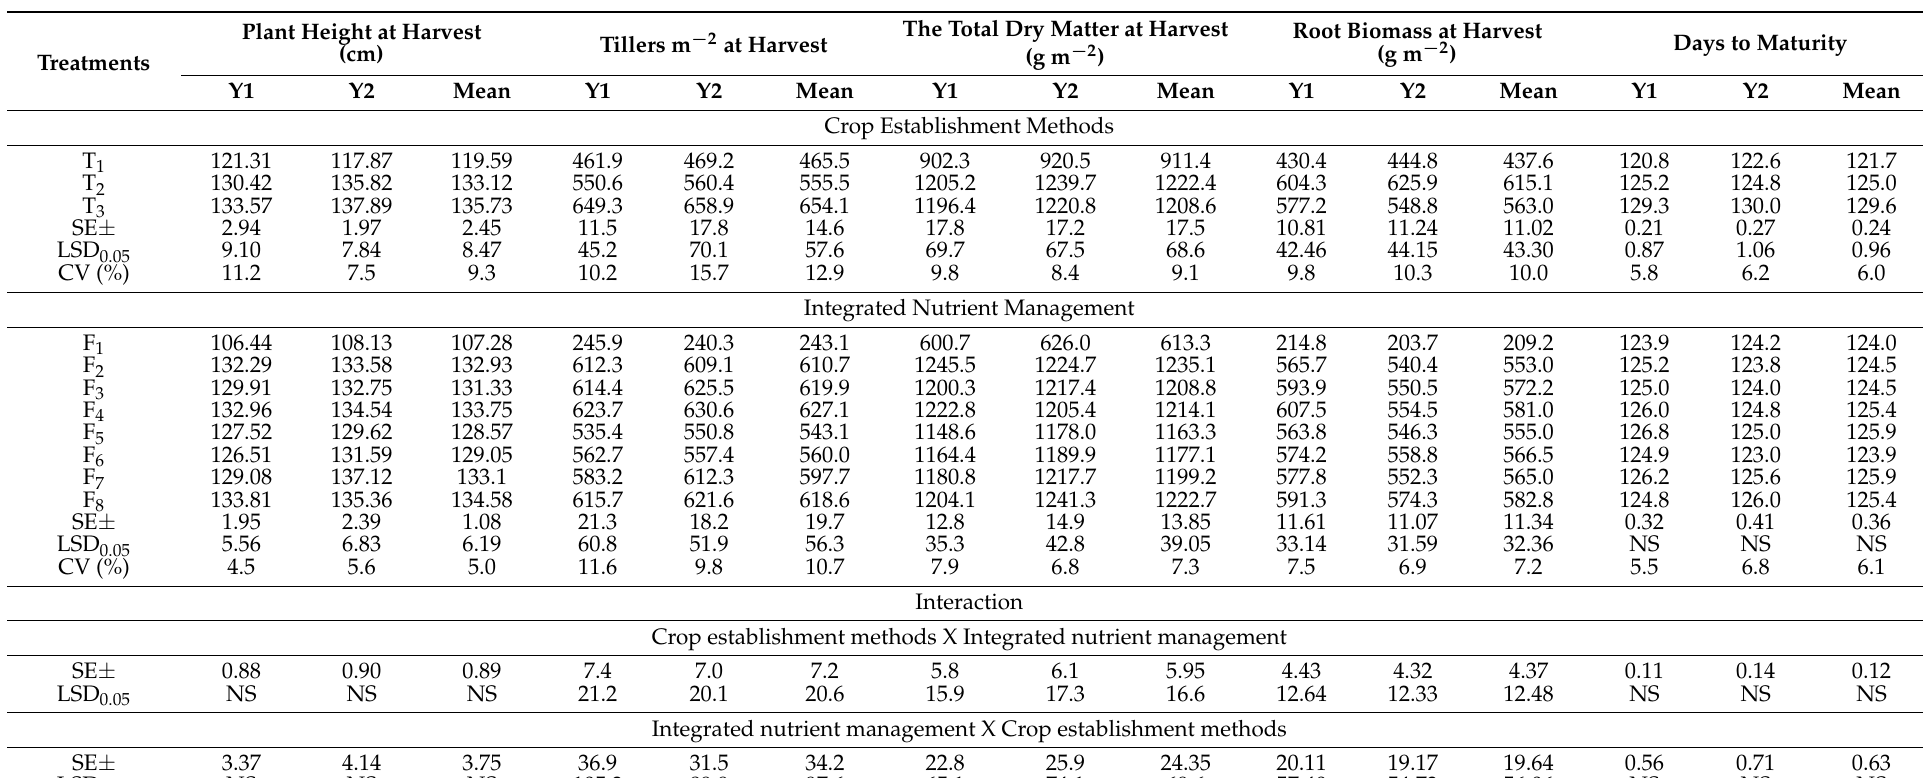
Table 2. Crop establishment methods and integrated nutrient management influenced the growth parameters of